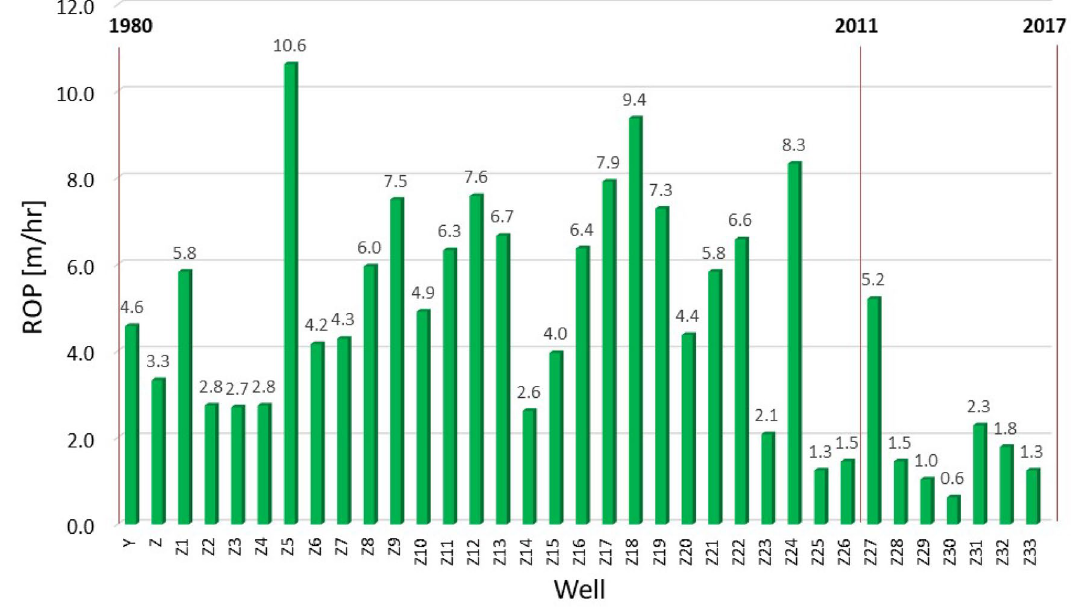
Fig. 4 The average ROP of drilling the 12 ¼-in. hole section (across Gachsaran formation) in 35 wells of Kupal